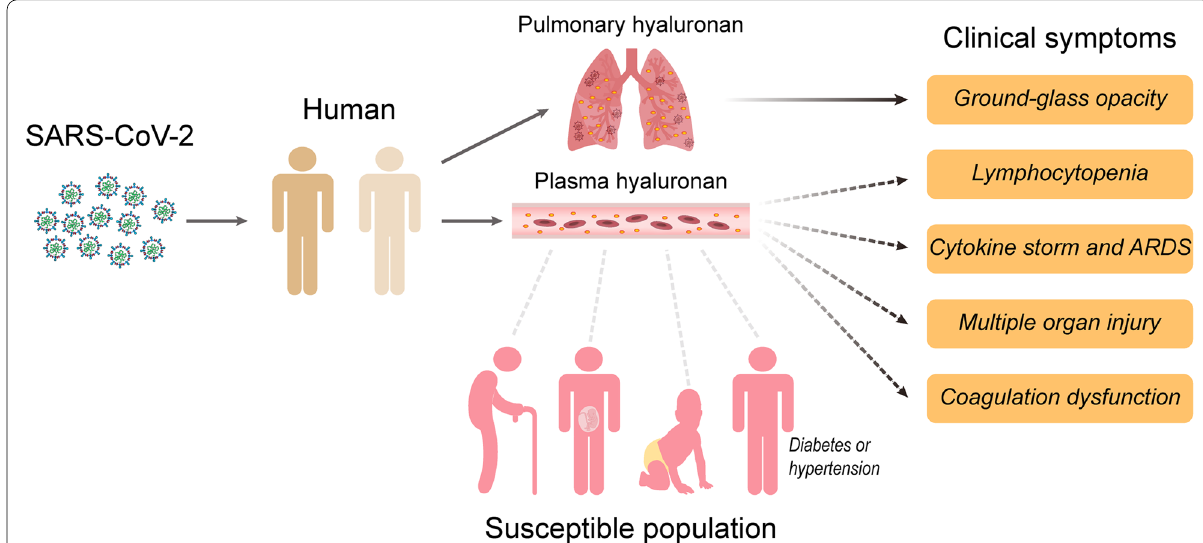
Fig. 4 The potential relationships between hyaluronan and COVID-19. The infection of SARS-CoV-2 accelerates the production of hyaluronan in blood and lung in COVID-19 patients. The accumulation of hyaluronan in lung directly causes the ground-glass opacity, which further develops consolidation. Additionally, the plasma hyaluronan is closely related to other clinical symptoms including lymphocytopenia, cytokine storm, ARDS, multiple organ injury, and coagulation dysfunction. Notably, the most susceptible population of SARS-CoV-2 have a high level of plasma